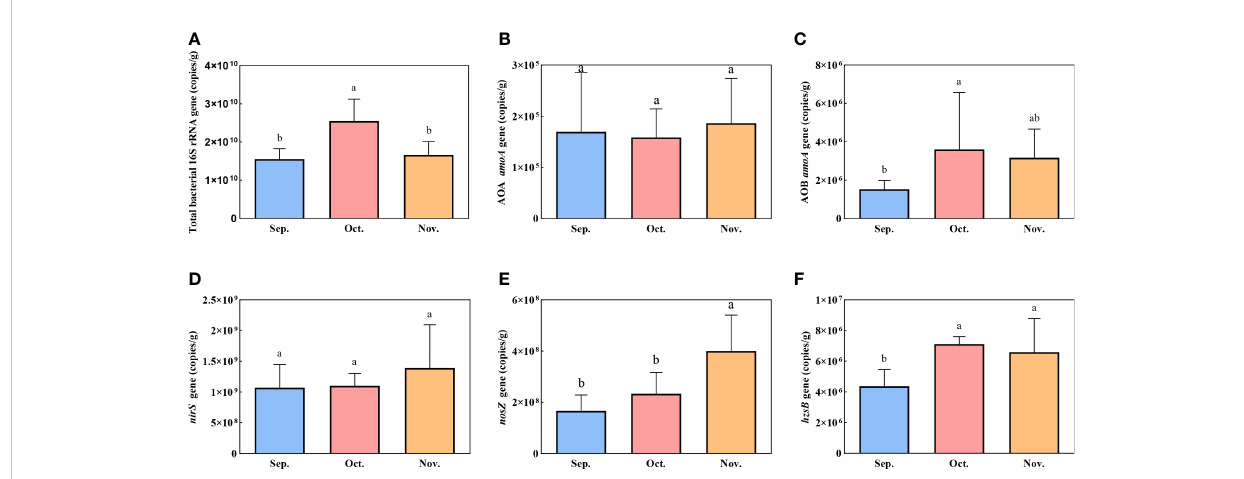
FIGURE 5 Spatial variation of gene copies for 16S rRNA (A) and associated with nitri fi cation and denitri fi cation: AOA amoA (B) , AOB amoA (C) , nirS (D) , nosZ (E) , and hzsB (F) . Error bars indicate standard deviation. The superscripts without same letter in the same row indicate signi fi cant difference ( P